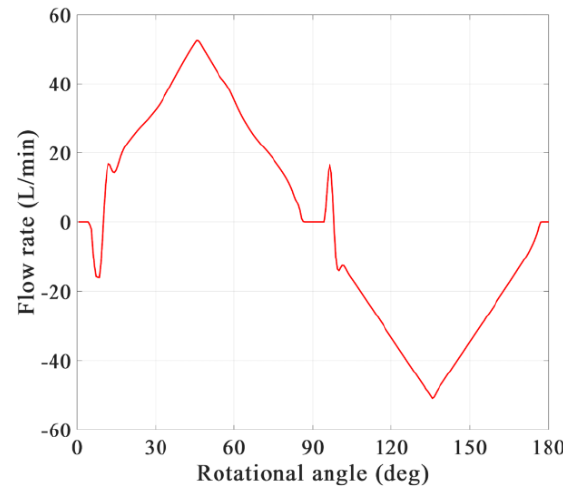
Figure 12. The outlet and inlet flow in the LLC. The grid model of the pump unit is shown in Figure 13. Both the inlets and outlets are set as the pressure inlet and outlet, and the set pressures are 0.4 MPa and 8 Mpa, respectively.